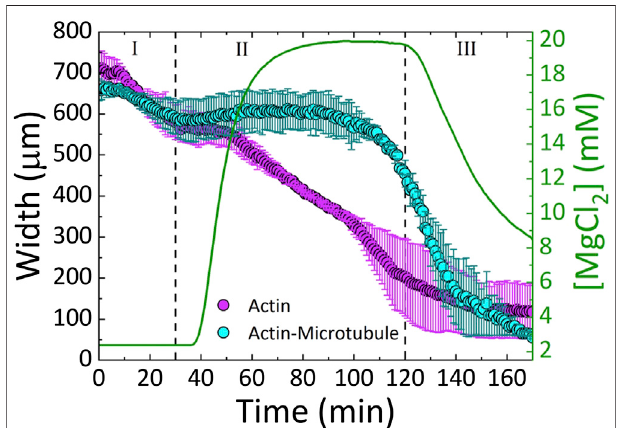
FIGURE 3 | Actin and actin-microtubule networks contract in response to continuous variation of Mg 2+ concentration. The average width (left axis) of the actin network samples (magenta) and actin-microtubule network samples (cyan) as a function of time. The Mg 2+ concentration (right axis) is also plotted (green line) as a function of time. The three phases of the experiment (I-III) are separated by dashed lines: I) 2 mM Mg 2+ solution (original polymerization buffer) diffuses through the sample for 30 min II) exchange to 20 mM Mg 2+ buffer is initiated and proceeds until 120 min III) 2 mM Mg 2+ buffer is reintroduced for 50 min.